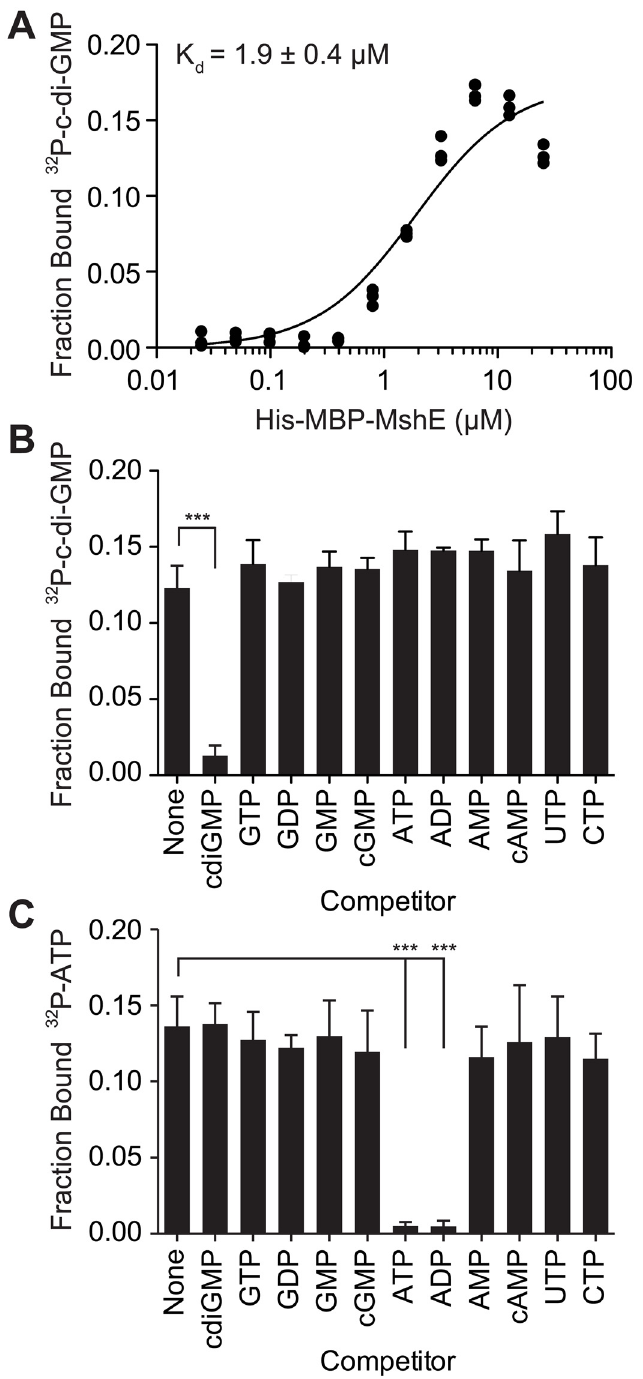
Fig 2. C-di-GMP bind to MshE ATPase with high affinity, specificity and independently of ATP. (A) Fraction bound 32 P-c-di-GMP to decreasing concentrations of purified His-MBP-MshE. The dissociation constant (K d ) is indicated. Fraction bound of His-MBP-MshE to (B) 32 P-c-di-GMP and (C) 32 P-ATP in the presence of 100 μ M nucleotide competitors. P-value was determined by two-tailed t-test ( *** p (cid:1) 0.001). All data are average of three independent assays and standard deviation is indicated by error